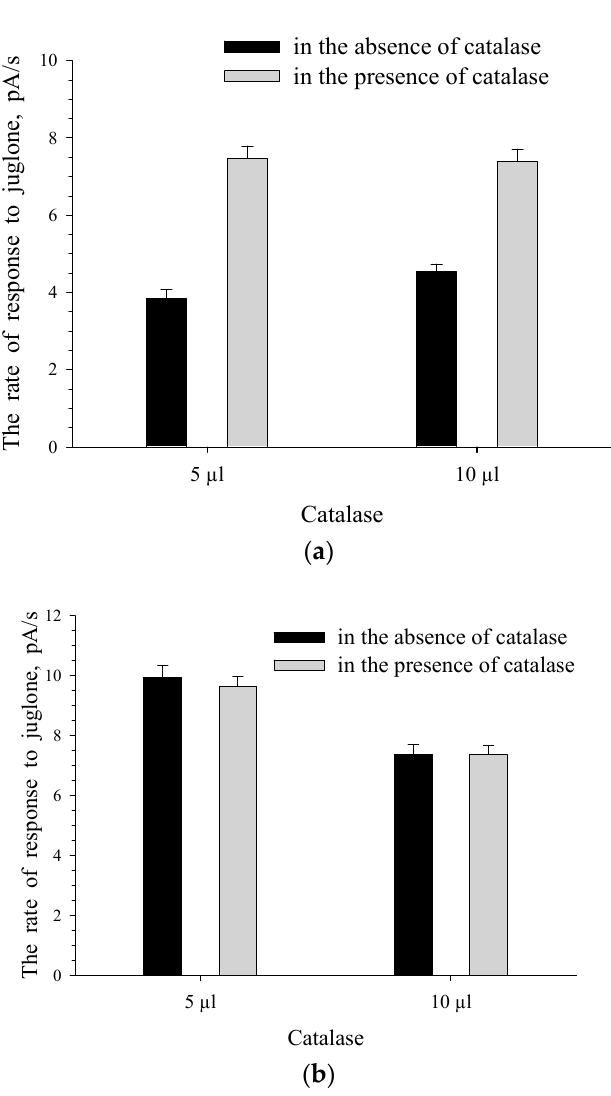
Figure 6. Response to the quinone form ( a ) and phenolate form ( b ) of juglone for immobilized cells of Pseudomonas sp. 4(c4) in the absence and presence of